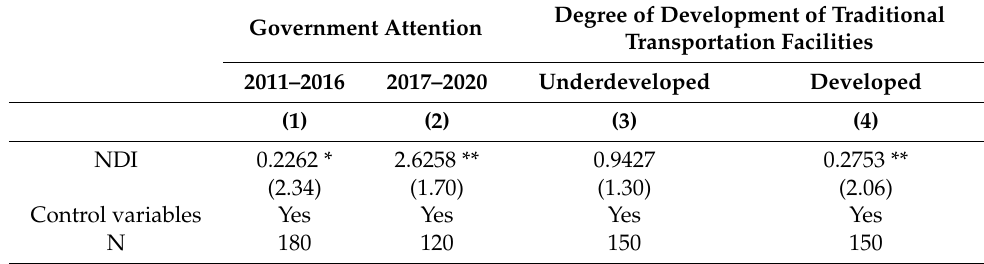
Table 11. Heterogeneity